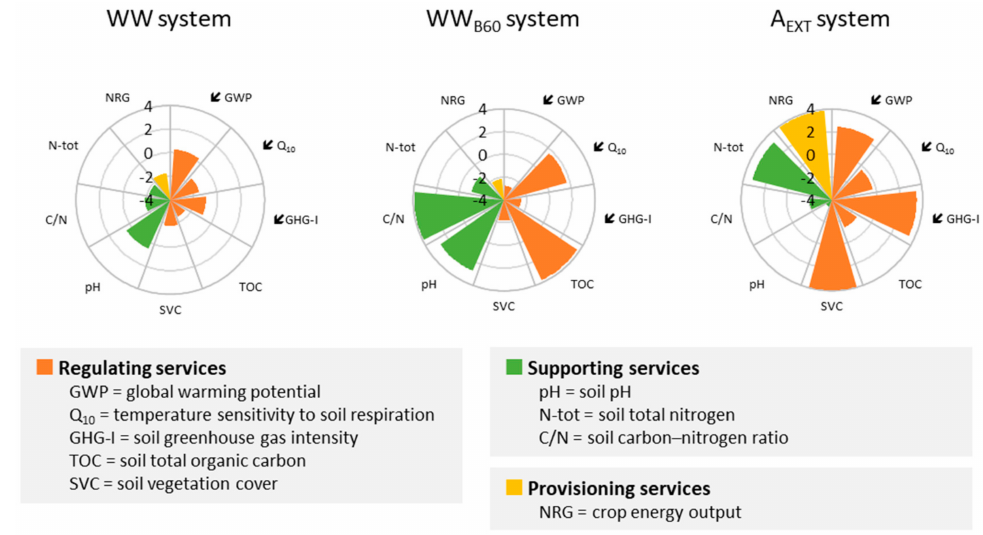
Figure 4. Relative contributions of each management system to provisioning of the ecosystem services. The data are based on the averages of the standardised values for the various indicators considered. WW, alfalfa followed by wheat for 2 years, control; WW B60 , alfalfa followed by single biochar application followed by wheat for 2 years; A EXT , alfalfa extended for 2